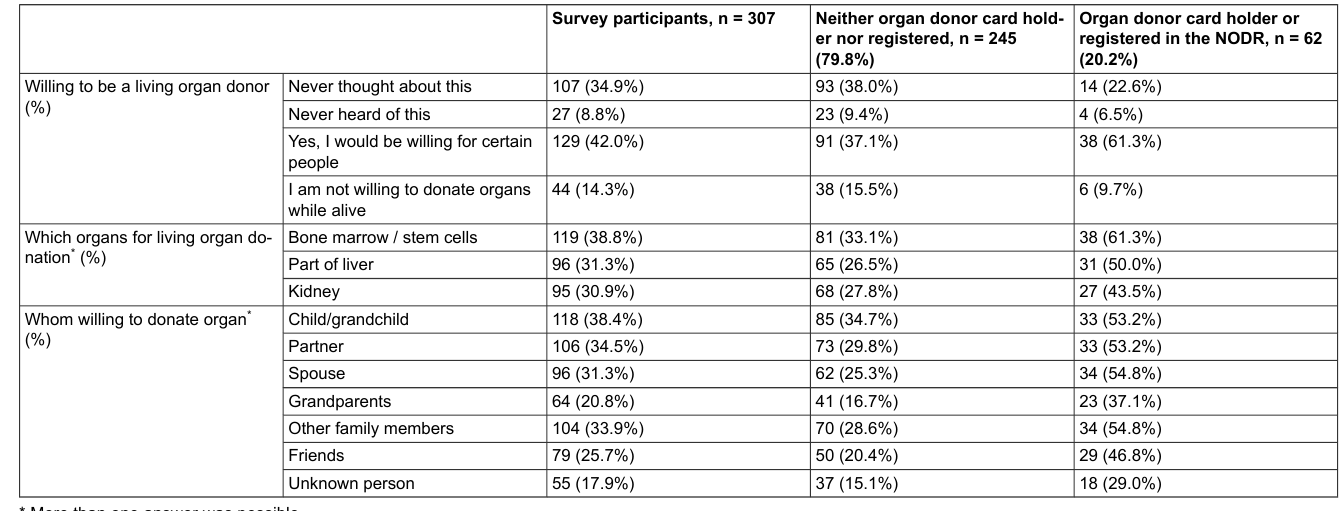
Table 6: Living organ